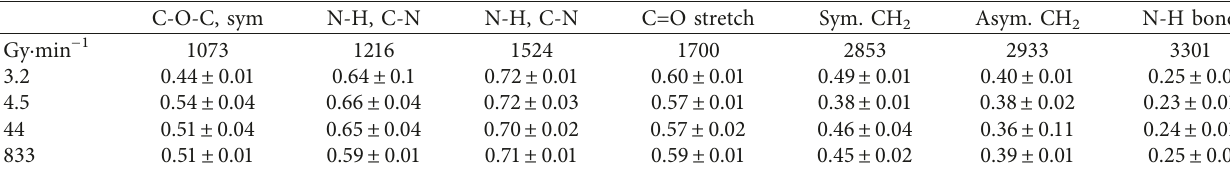
Table 2: FTIR Peak area data showing slight differences in bonds ( n � 20).